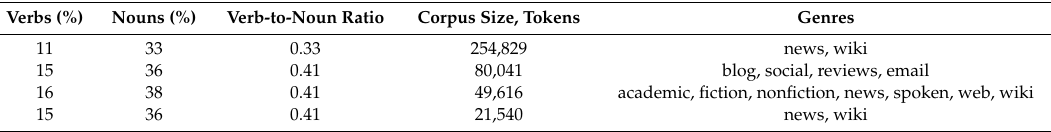
Table 2. Distribution of nouns and verbs across genres in English. 8